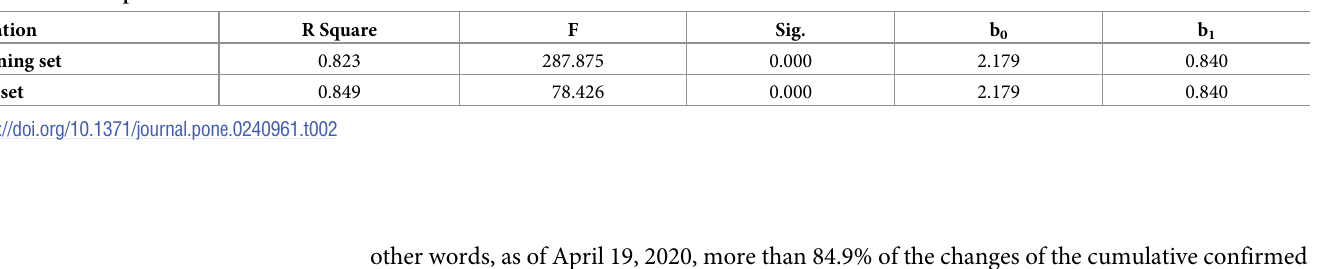
Table 2. Estimated parameters of cumulative confirmed cases of COVID-19.